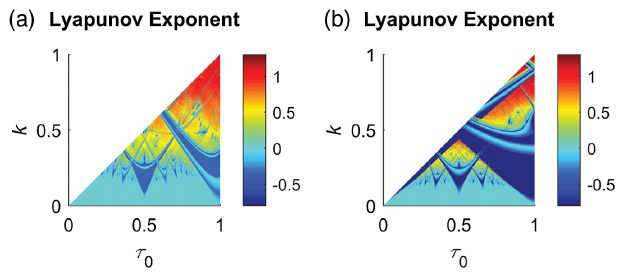
FIG. 5. Maximal Lyapunov exponent for α ¼ − 0 . 5 (a) and α ¼ 0 . 2 (b). The blue areas (negative Lyapunov exponent) are periodic areas. The cyan areas are quasiperiodic (zero Lyapunov exponent), and the red, yellow, and green represent the chaotic areas (positive Lyapunov exponent). The maximal Lyapunov exponent was computed as explained in Ref. [52]. The parameters in (a) are identical to those of Fig. 3(a), and similar features such as Arnold tongues are observed.